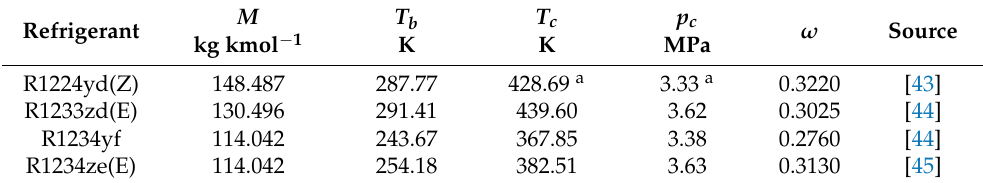
Table 2. Physical properties for the studied alternative